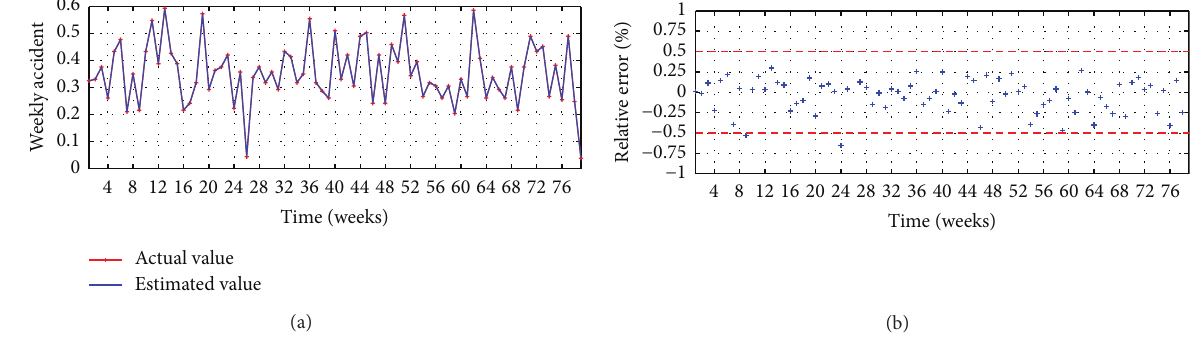
Figure 7: SVD-ARIMA(9,0,11): (a) observed versus estimated and (b) relative error.